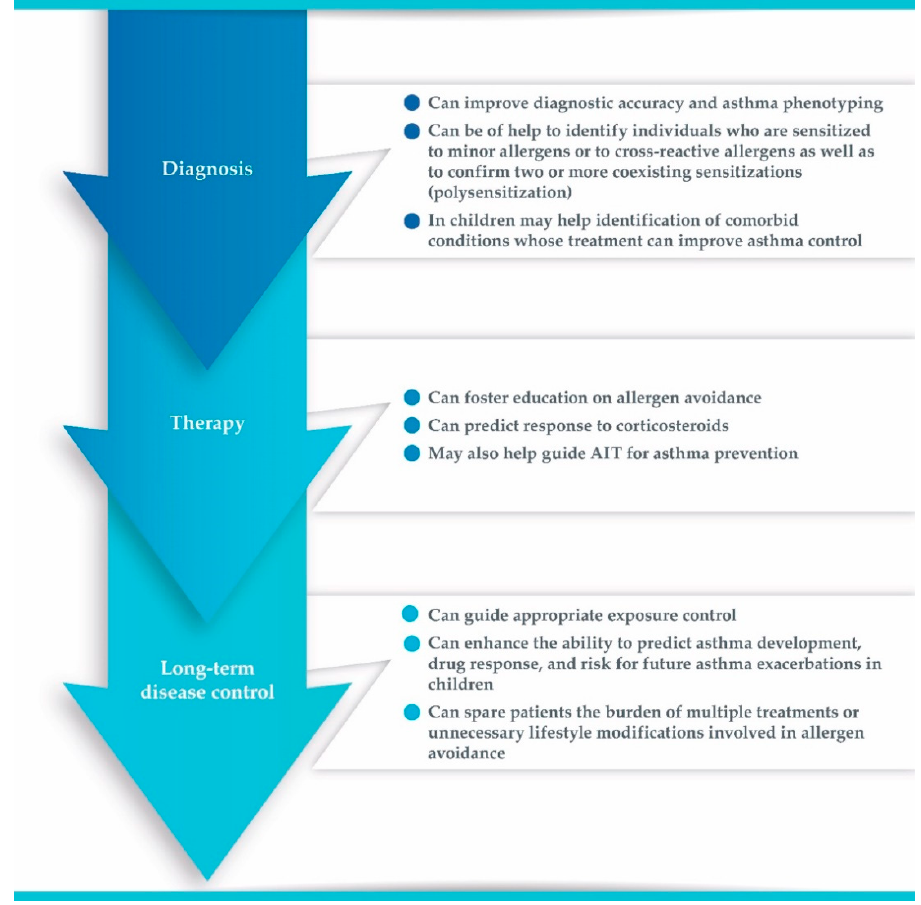
Figure 1. Relevance of allergen testing across asthma patient journey. AIT, allergen